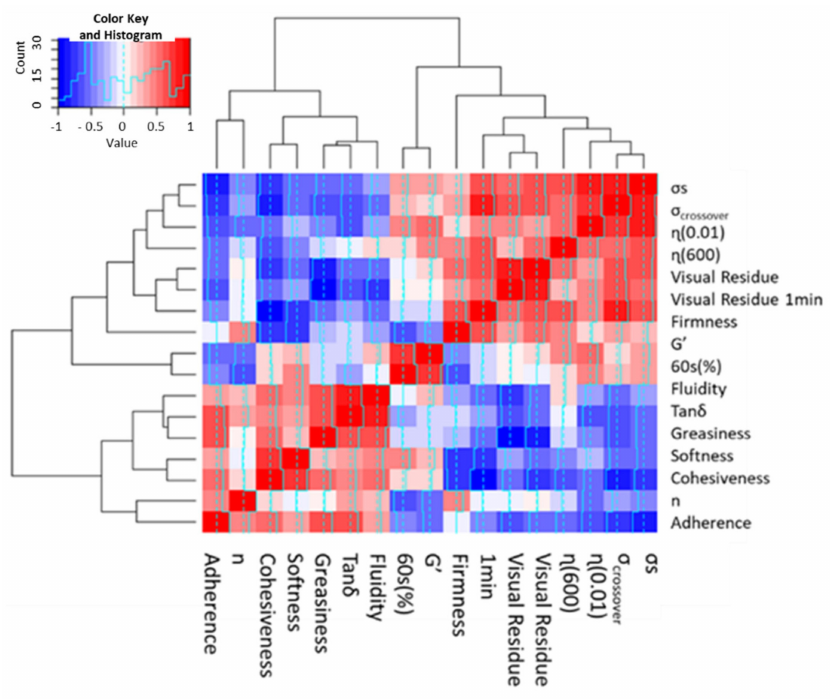
Figure 11. Heatmap of the correlations with the selected attributes and